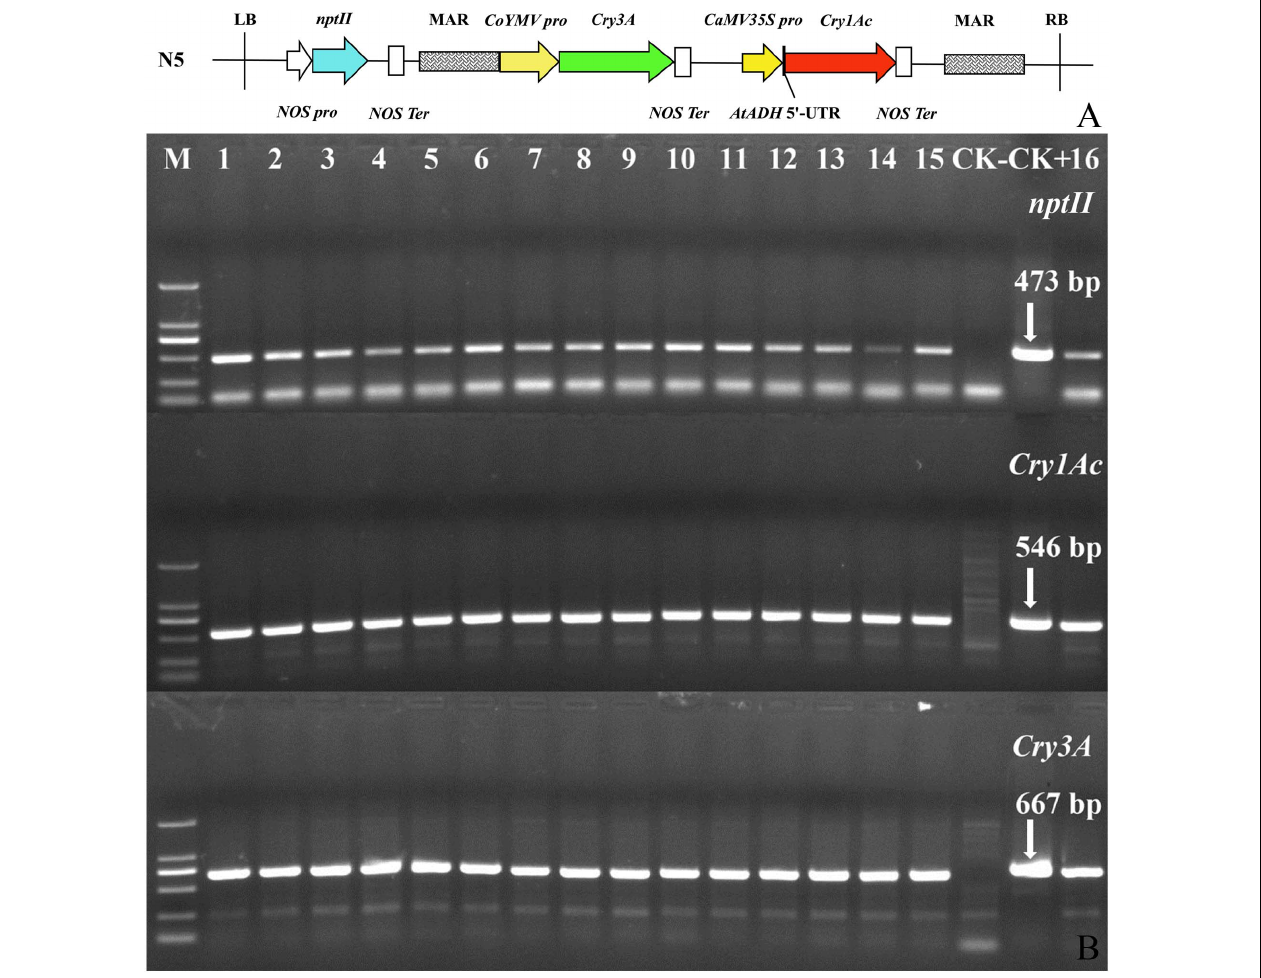
FIGURE 1 | T-DNA structure of plant expression vector N5 and PCR confirmation of transgenic dual Bt toxin Populus × euramericana ‘Neva’ lines. (A) T-DNA structure of plant expression vector N5. Each target gene has a respective promoter and termination sequence in the vector, and the genes are located between the left and right T-DNA borders in the vector. N5, the name of the plant expression vector; LB, vector left boundary; NOS pro , promoter of neomycin phosphotransferase gene; nptII , neomycin phosphotransferase gene; NOS Ter , terminator of neomycin phosphotransferase gene; MAR, the molecular structure of the matrix attachment region of tobacco; CoYMV pro , commelina yellow mottle virus promoter; Cry3A , bacillus thuringiensis insecticidal crystal protein gene; CaMV35S pro , cauliflower mosaic virus CaMV35S promoter; AtADH 5 (cid:48) -UTR, translation enhancer; Cry1Ac , bacillus thuringiensis insecticidal crystal protein gene; RB, right boundary of vector. (B) PCR confirmation of transgenic dual Bt toxin Populus × euramericana ‘Neva’ lines. M: DL2000 DNA Marker (From top to bottom, bands correspond to 2,000, 1,000, 750, 500, 250, and 100 bp); 1–16: sixteen rooting lines; CK − , non-transgenic control; CK+, positive control (plasmid N5).